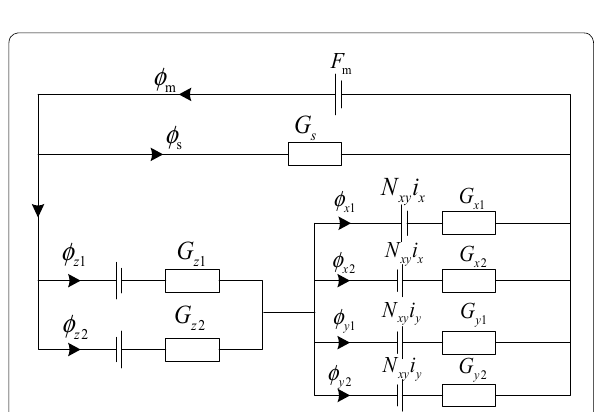
Figure 4 Equivalent hybrid excitation magnetic circuit of